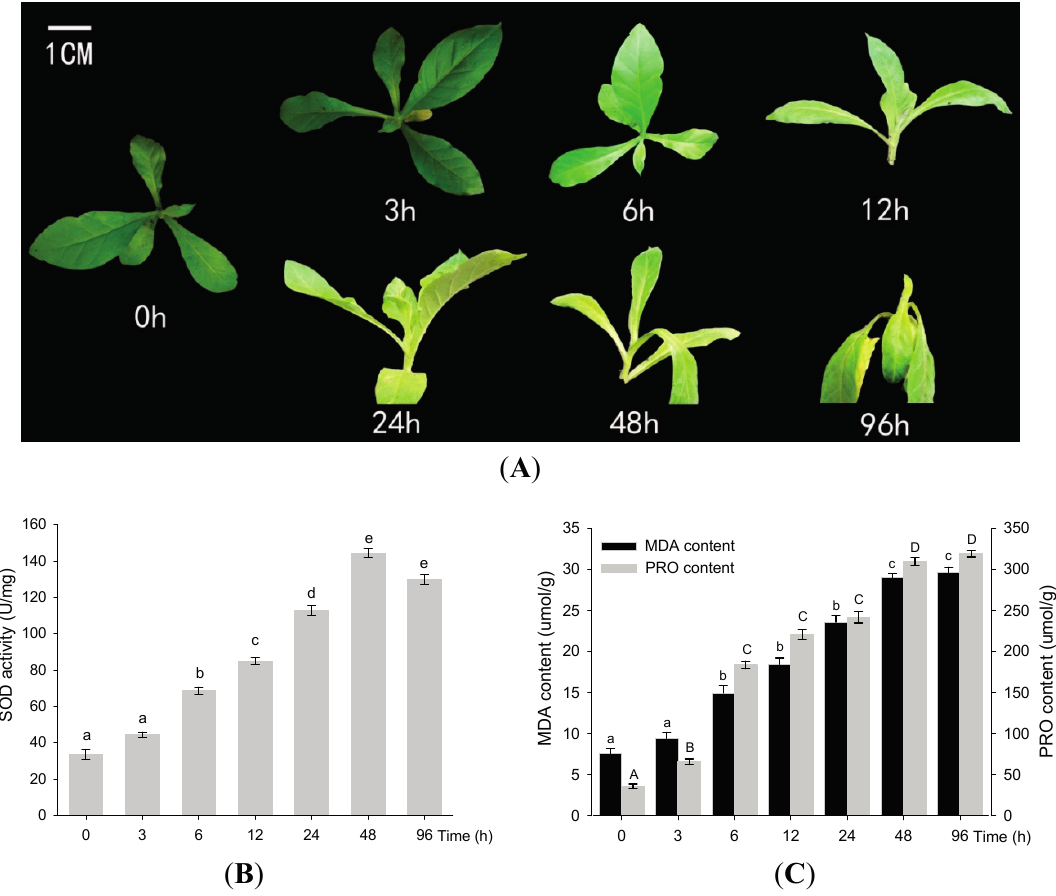
Figure 1. The growth status of tobacco under drought stress and corresponding physiological analyses. ( A ) The growth status of control plant (0 h) and drought-treatment plants at six time-points (3, 6, 12, 24, 48, and 96 h) with 20% PEG6000. The graphs ( B ) and ( C ) depicted the average change of superoxide dismutase (SOD) activities and contents of proline (PRO) and malondialdehyde (MDA), respectively, in the actual value ± standard error of the mean from control (time 0) across time for each treatment. Different lower or upper cases above standard error denoted the significantly difference of every two time –points (one-way ANOVA and Fisher’s LSD , p < 0.01, n = 3), whereas the same letter indicated no highly significant difference ( p < 0.01). The gray bars in graph C represent the contents of PRO (µmol/g) and the black bars, the contents of MDA (µmol/g) at time 0 and six drought-treatment time-points. Time 0 represented the level obtained from the normal seedlings with six